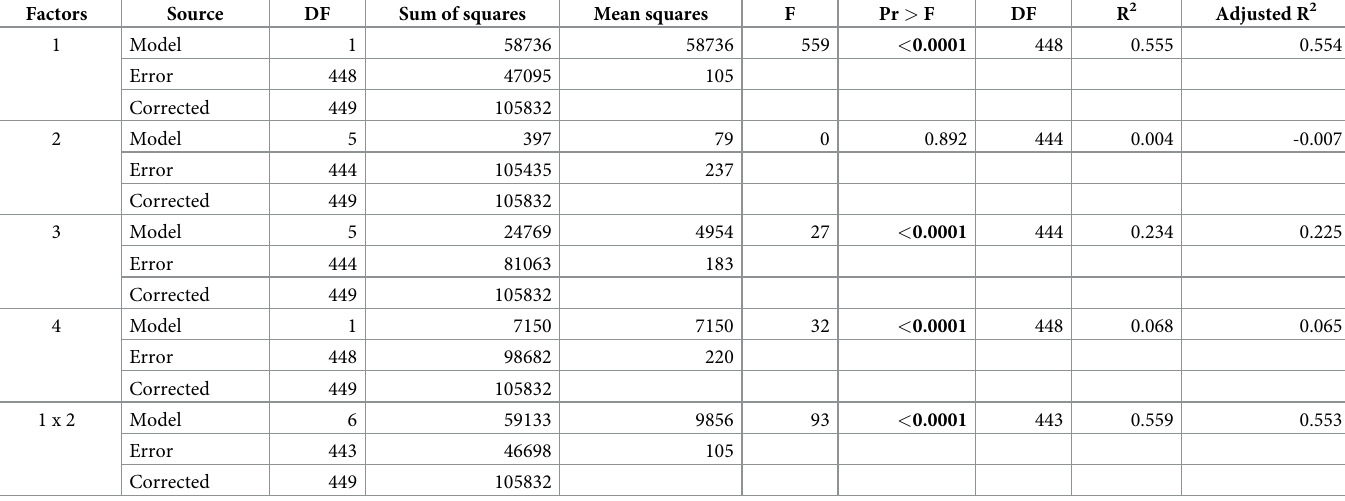
Table 7. ANOVA table for the dimensionless parameter PMT%CL of the dorsal fin and tail fluke cross-sections with the independent factors fin type (Factor 1), sec- tion # (Factor 2), species (Factor 3) and body length (Factor